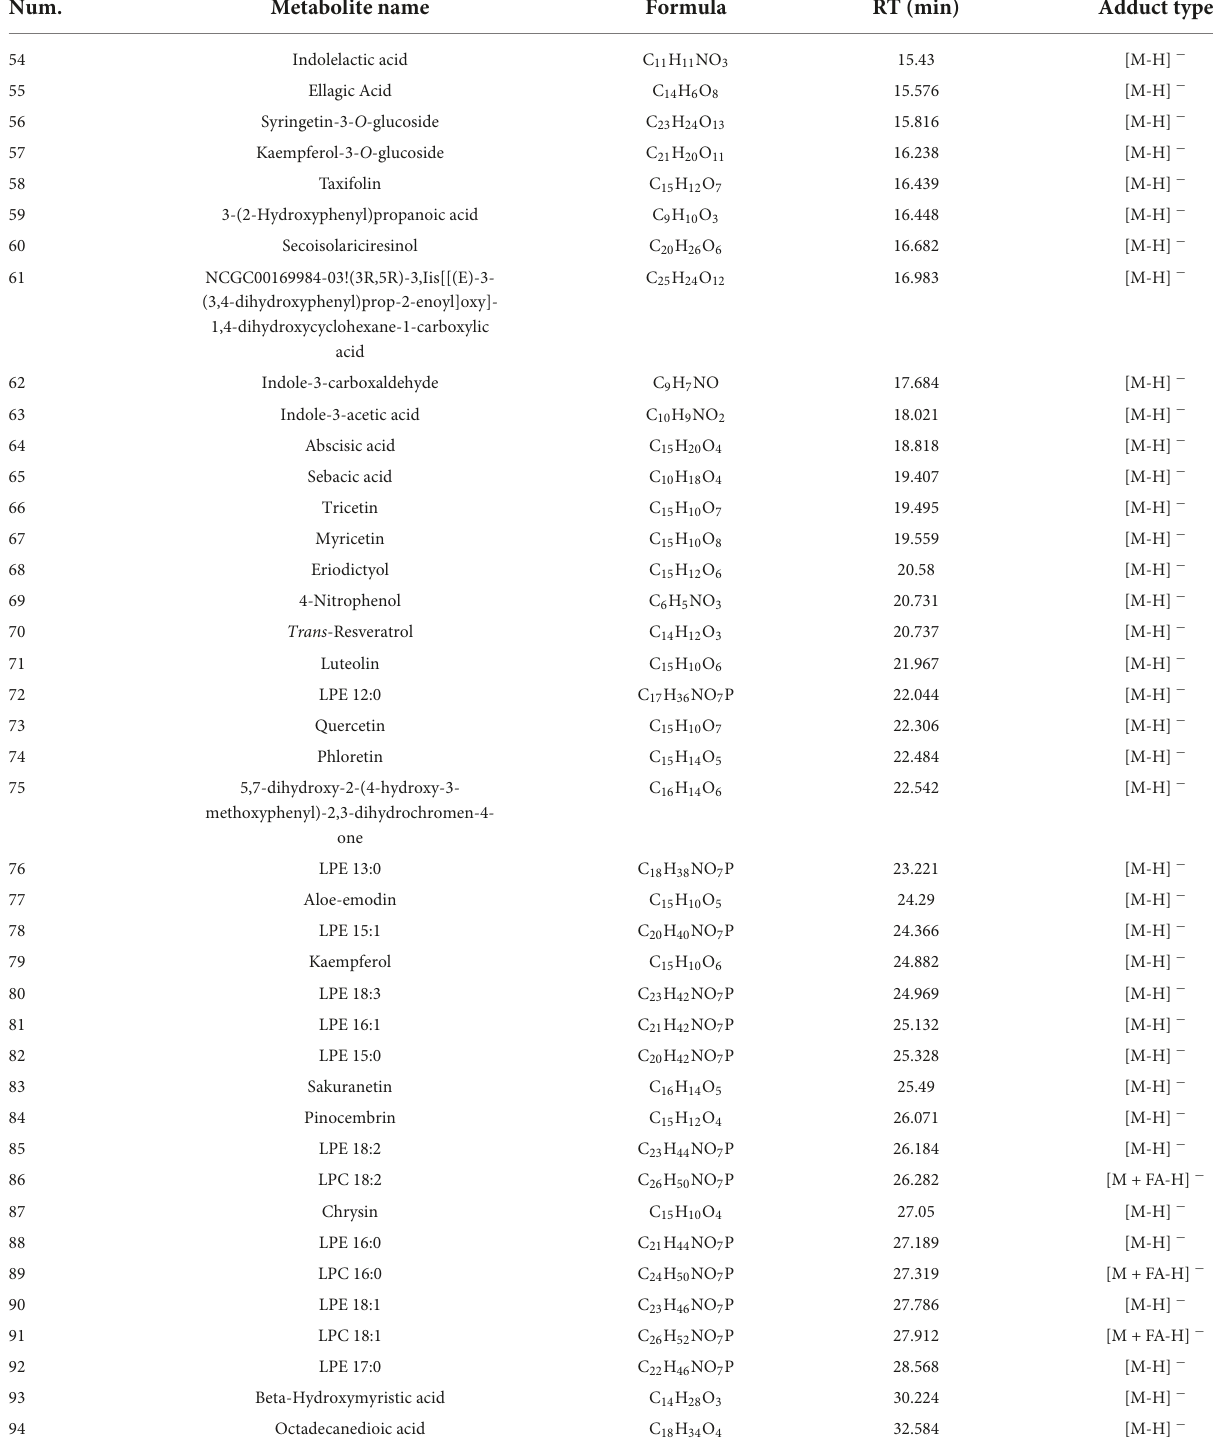
( Figure 4E ), while is down-regulated by application of 10 µ m exogenous NPA ( Figure 4G ), an inhibitor of auxin transport, and the expression in both treatment groups gradually return